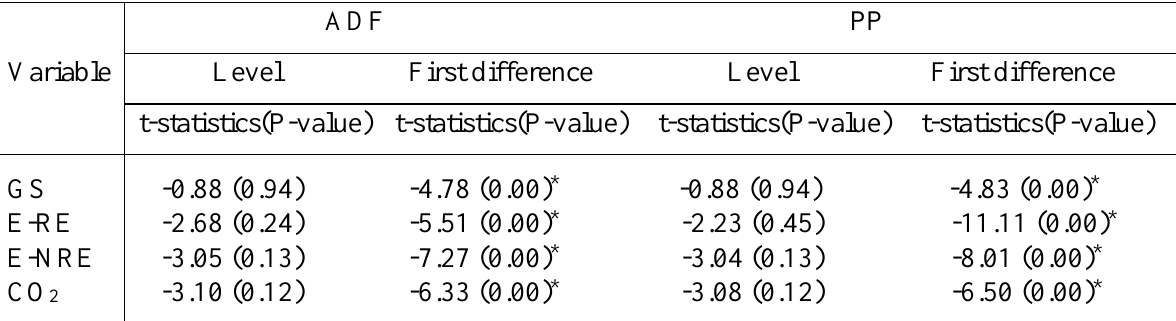
Table 1. Results of unit root tests